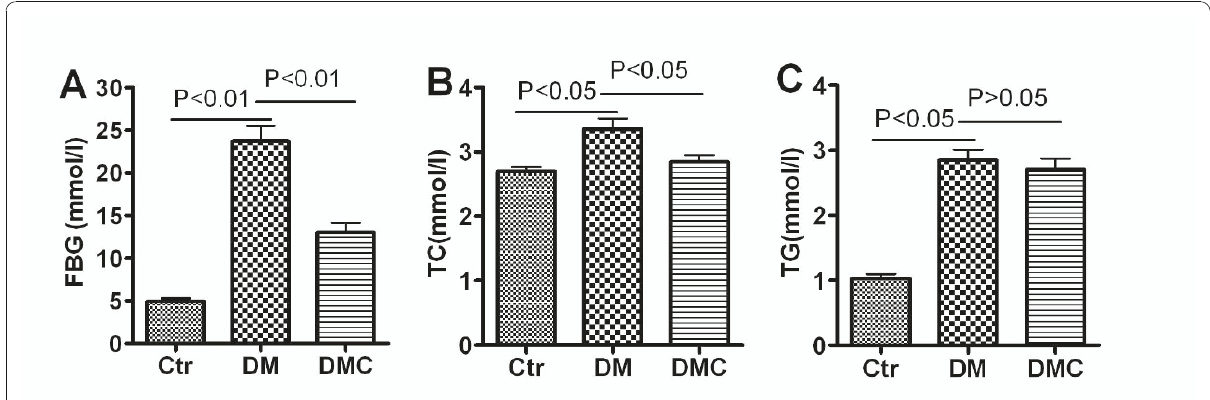
Figure 1 Effects of DMC on FBG, TG and TC in diabetic rats . FBG: fasting blood glucose; TG: triglycerides; TC: total cholesterol. n = 10.